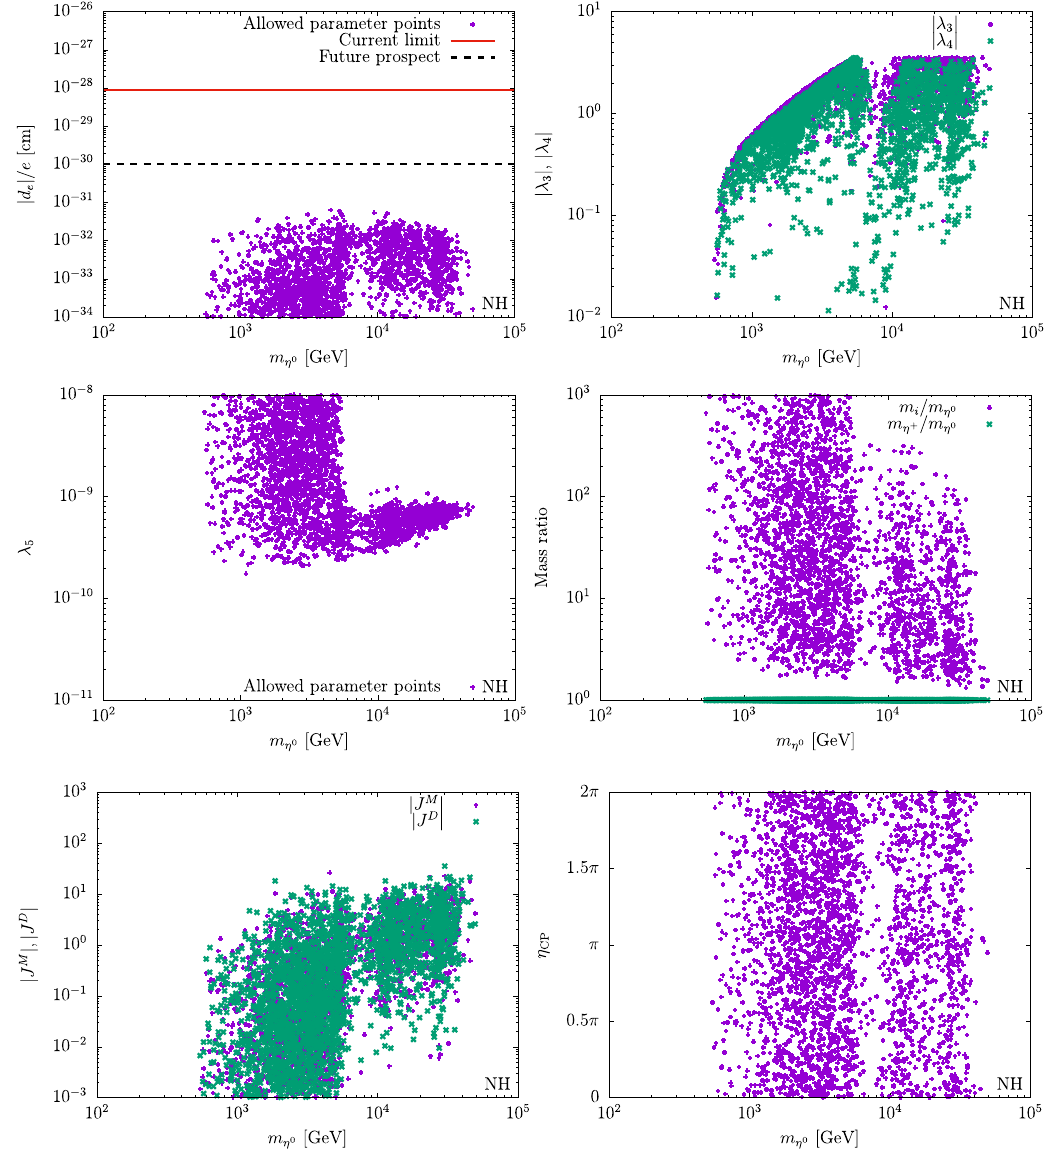
Figure 6 . Numerical results for scalar dark matter in the case of normal ordering of the light neutrino mass spectrum. Each point complies with all the constraints discussed in section